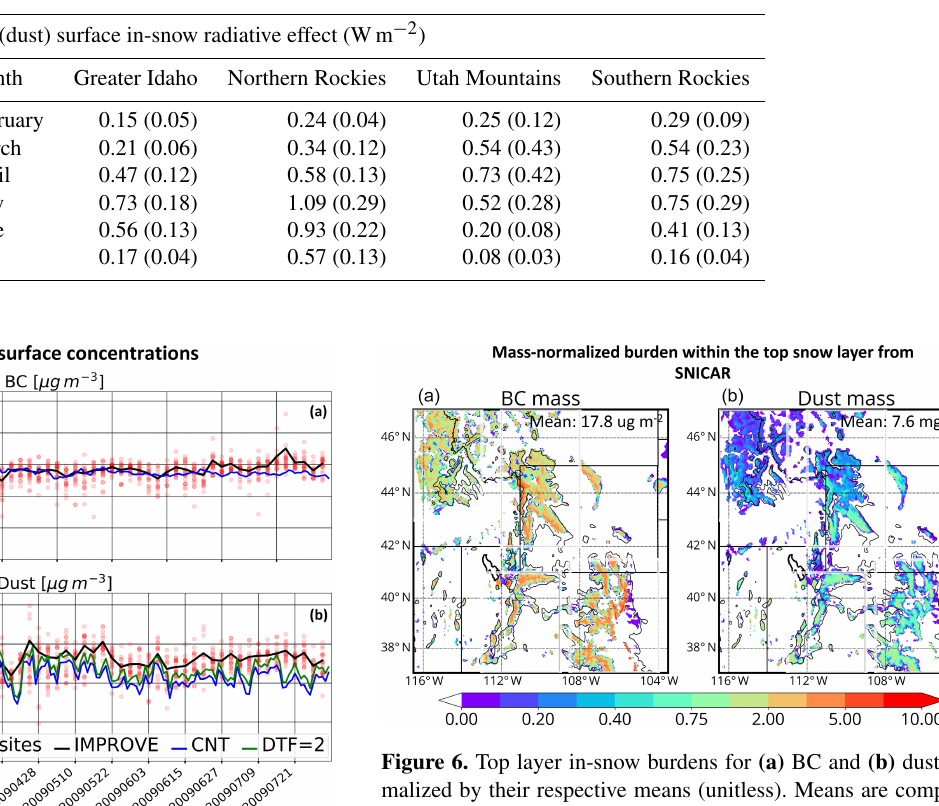
Table 3. Monthly averages of LAP in-snow radiative effect (Wm − 2 ) across the domain and subregions therein. Dust RE values are given in parentheses.